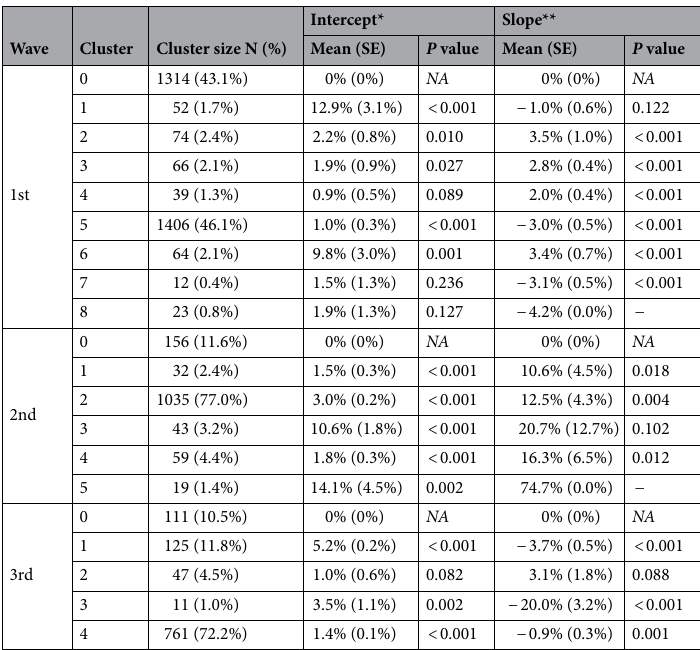
Table 4. GLMM clustering results. Clustering (based on COVID-19 MIR > 0) of the 1736 counties during the 1st wave (Mar 25–Jun 3, 2020), 1344 targeted counties (sunbelt region) during the 2nd wave (Jun 4–Sep 2, 2020), and 1055 targeted counties (great plains region) during the 3rd wave (Sep 3–Nov 12, 2020), USA. * Intercept indicates the estimated mean MIR of COVID-19 at the beginning of the wave, for each cluster. ** Slope indicates the overall change of MIR of COVID-19 during each wave, for each